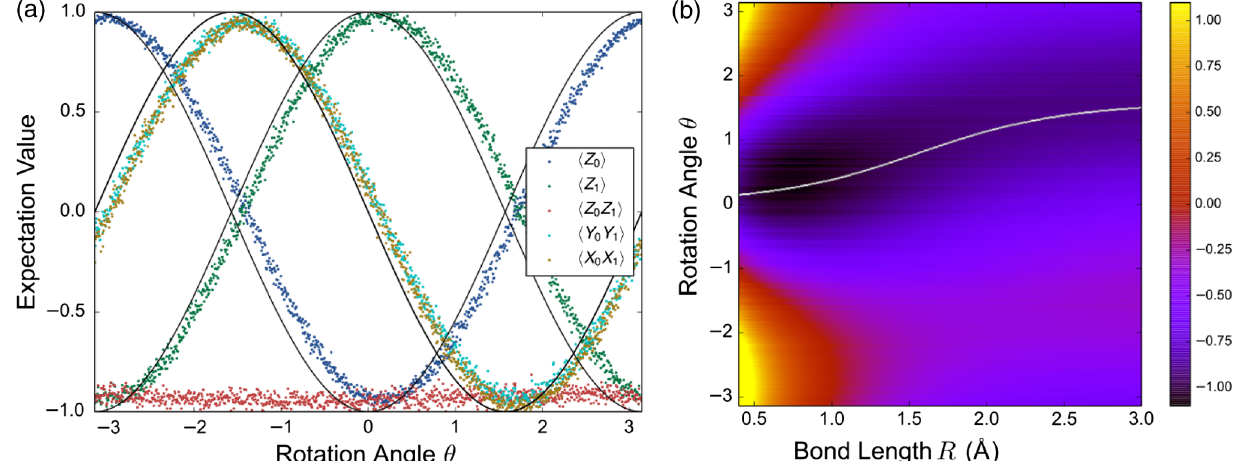
FIG. 2. Variational quantum eigensolver: raw data and computed energy surface. (a) Data showing the expectation values of terms in Eq. (1) as a function of θ , as in Eq. (3). Black lines nearest to the data show the theoretical values. While such systematic phase errors would prove disastrous for PEA, our VQE experiment is robust to this effect. (b) Experimentally measured energies (in hartree) as a function of θ and R . This surface is computed from (a) according to Eq. (4). The white curve traces the theoretical minimum energy; the values of theoretical and experimental minima at each R are plotted in Fig. 3(a). Errors in this surface are given in Fig.